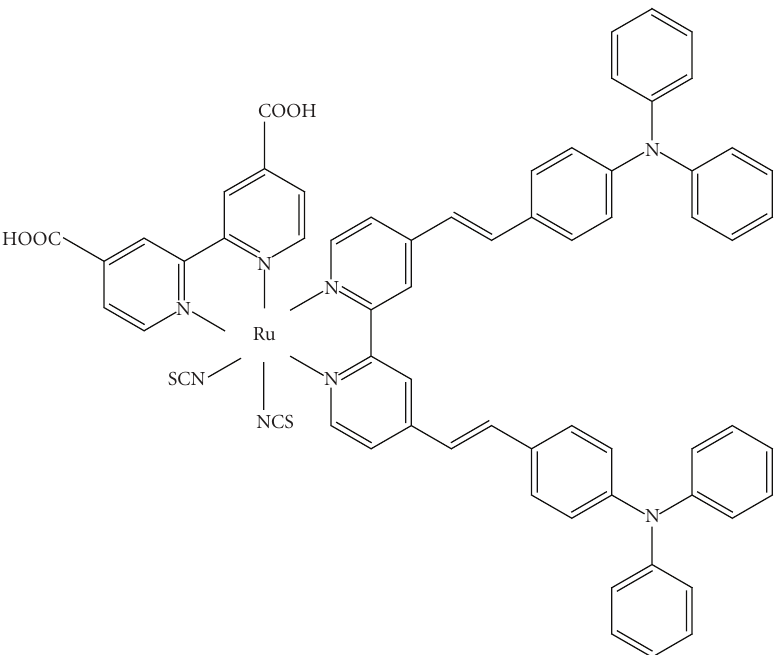
Figure 21: Molecular structure of Ru-TPA-NCS. Reprinted with permission from